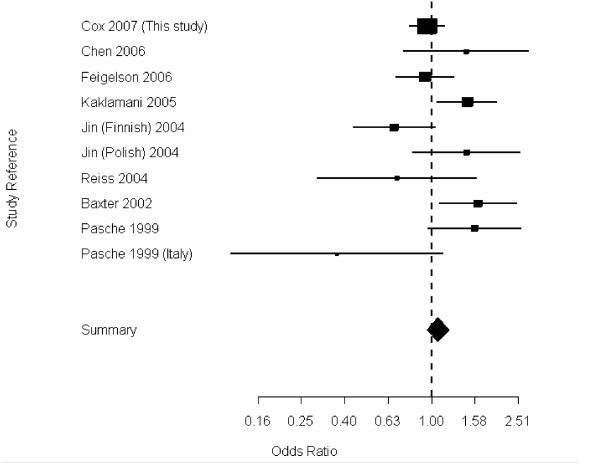
Random-effects meta-analysis of TGFBR1*6A under a dominant model.